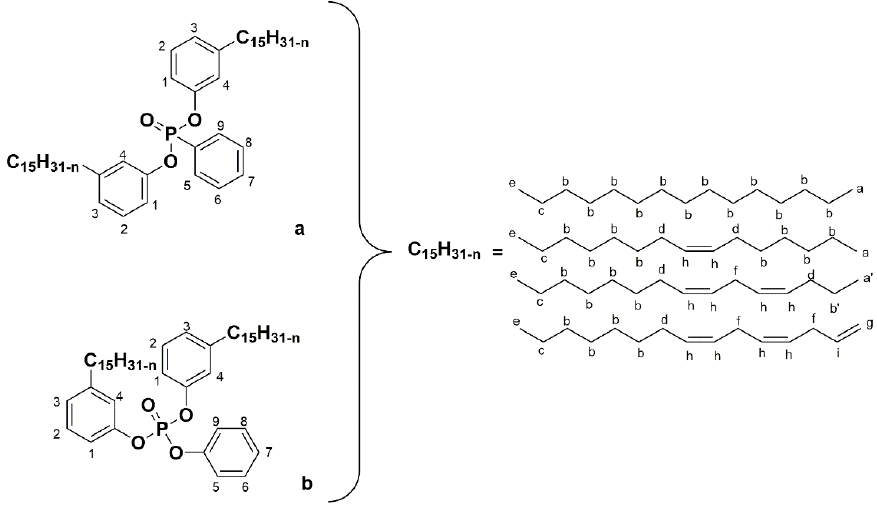
Figure 1. Structure of ( a ) phosphonate ‐ and ( b ) phosphate ‐ cardanol. 31 P NMR (161.6 MHz, CDCl 3 , ppm): δ : 11.5